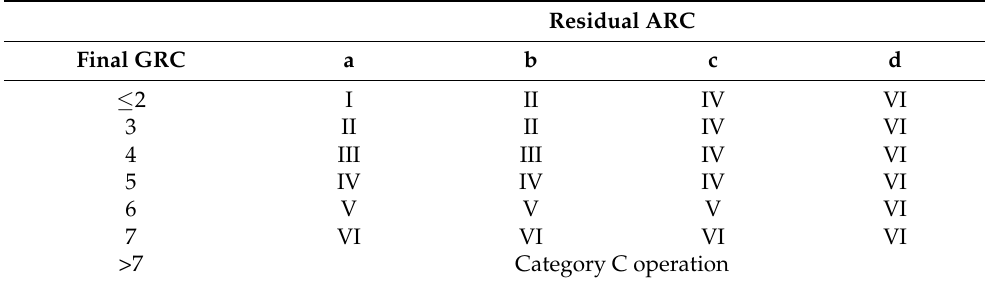
Table 2. The SAIL determination table adapted from [24] is used to obtain the SAIL assigned to a particular